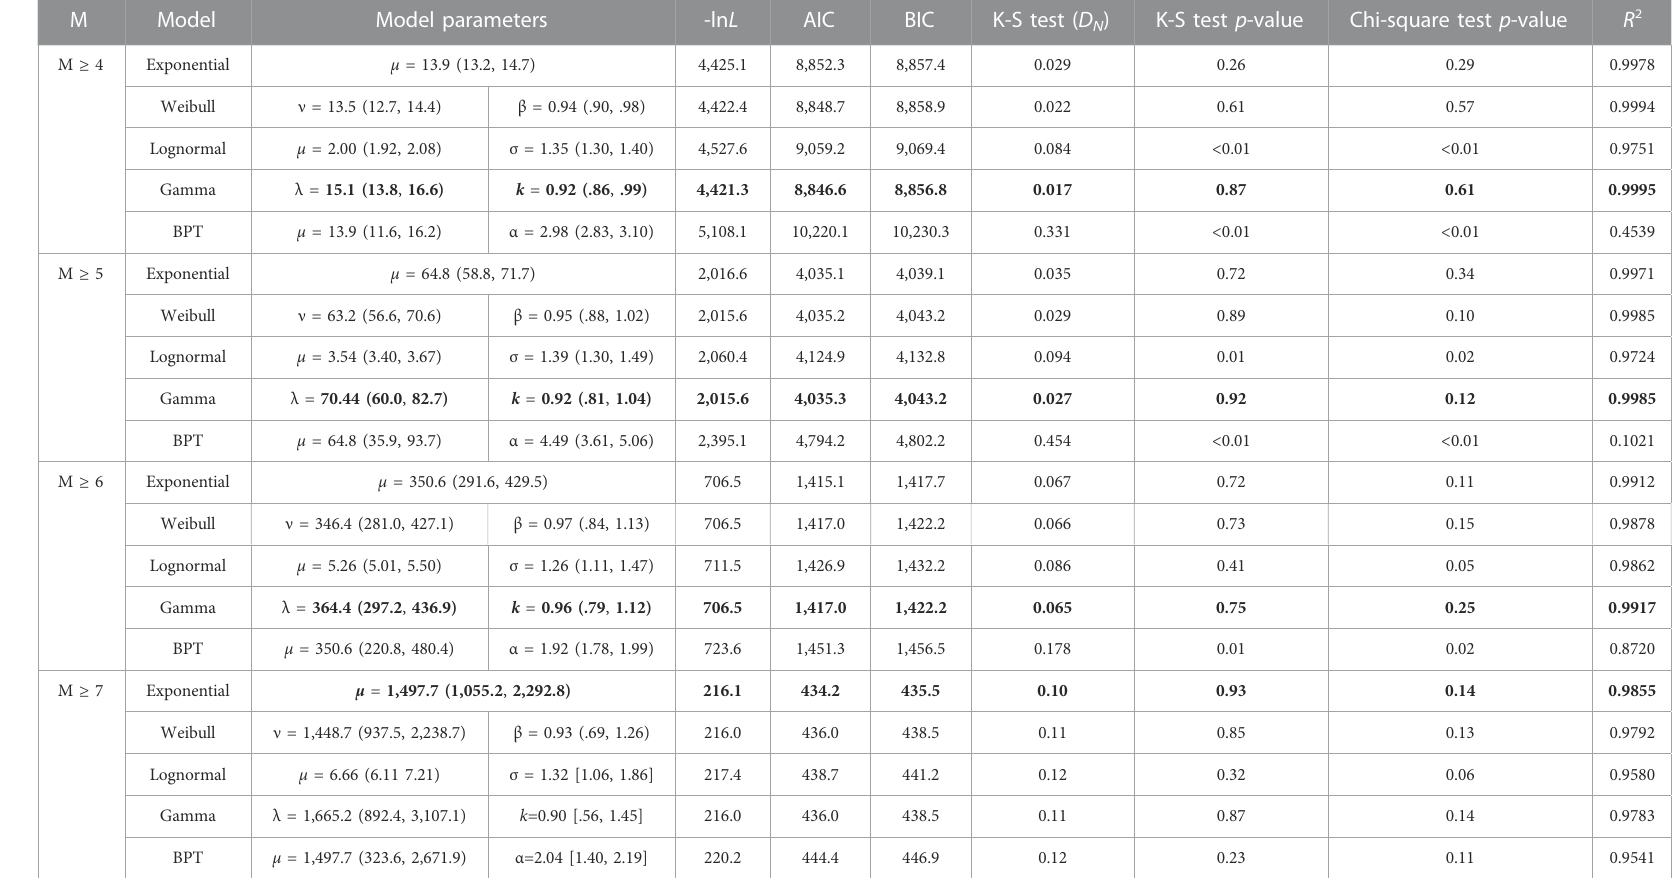
The best model using bold